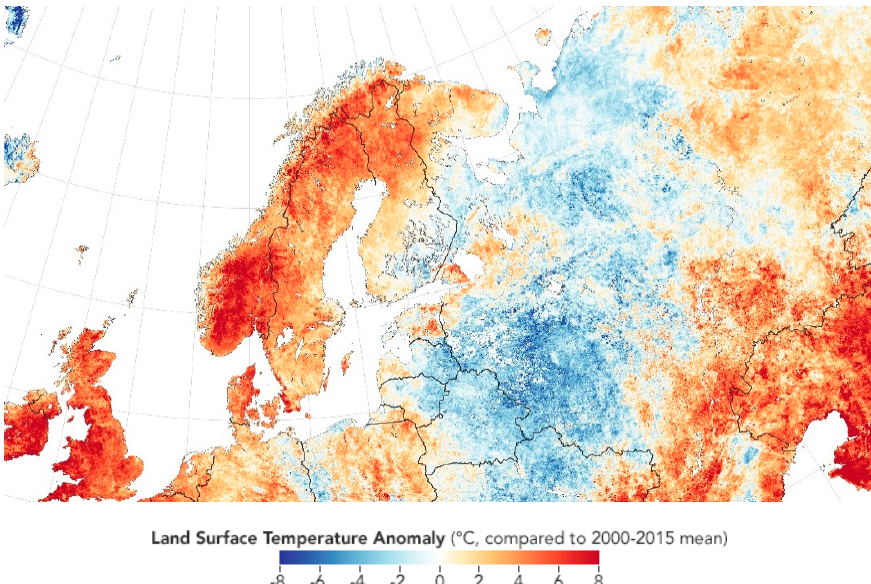
Figure 1. Temperature anomaly in Northern Europe in July (Source: NASA).